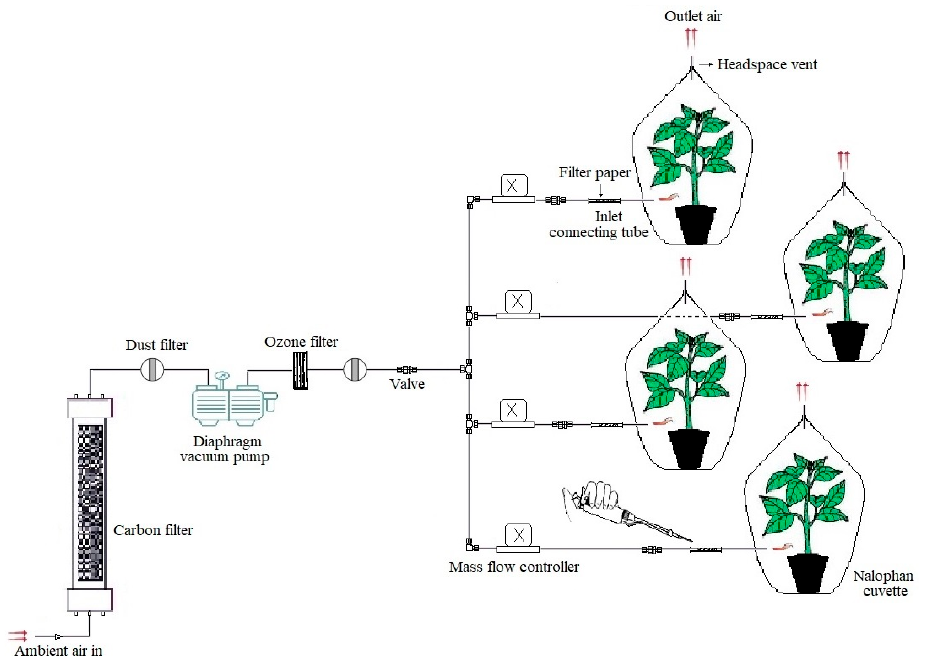
Figure 1. Schematic illustration of the modified push–pull cuvette system used in this study. Z-3- HAC (55 µL) was applied on a piece of filter paper inside the inlet-connecting tubes over 6 h with 1 h intervals. Tubing and connections were made out of perfluoroalkoxy alkane or stainless steel (Swagelok, Solon, OH, USA).